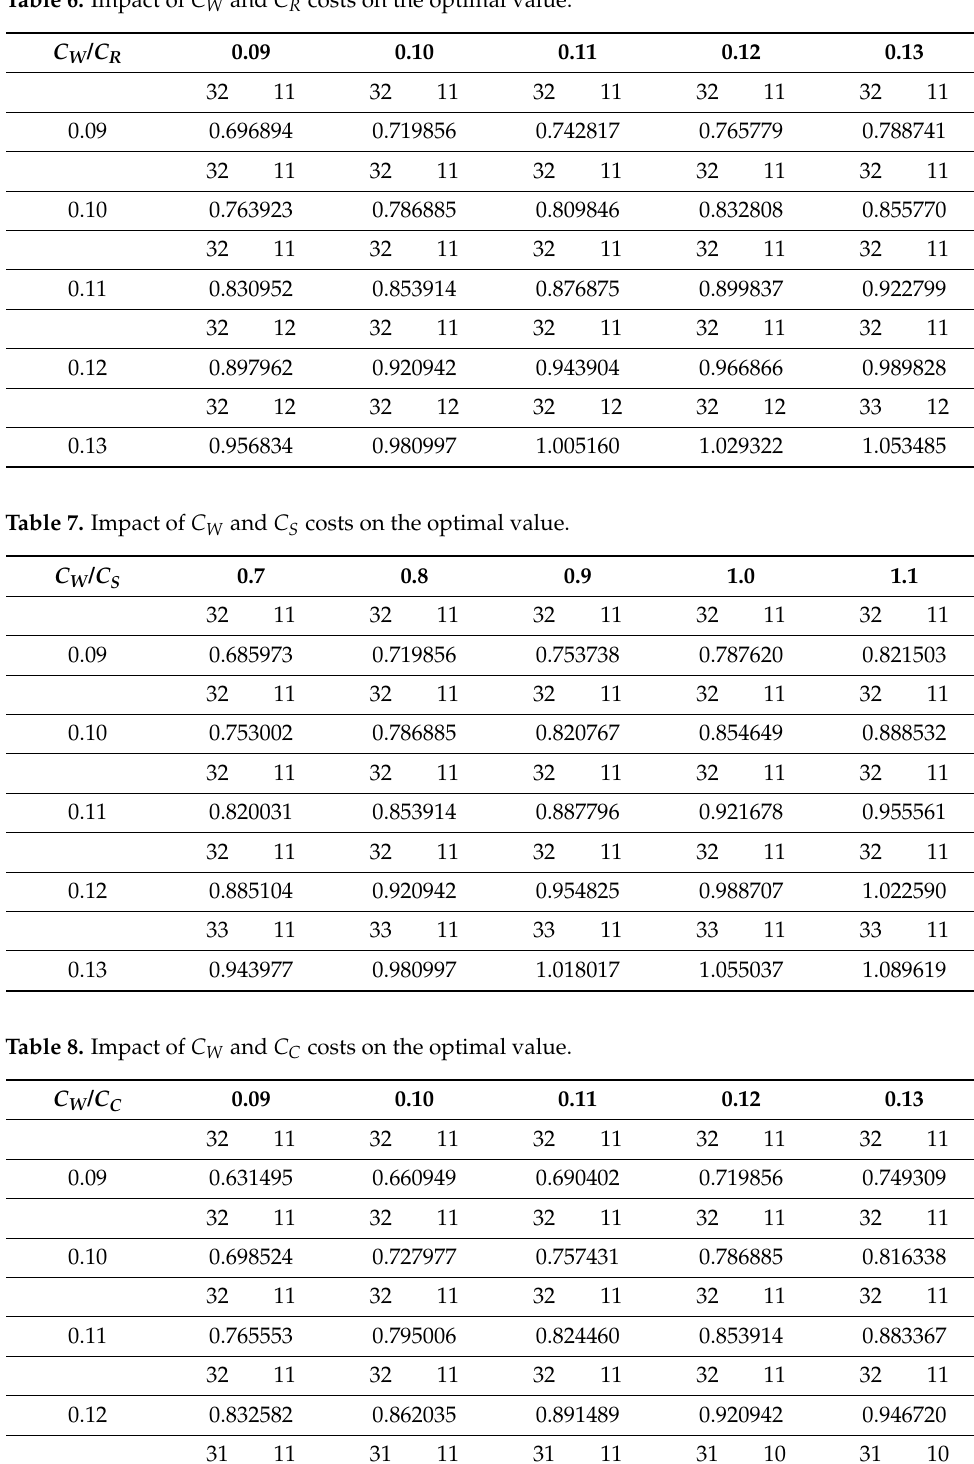
Table 6. Impact of C W and C R costs on the optimal value.